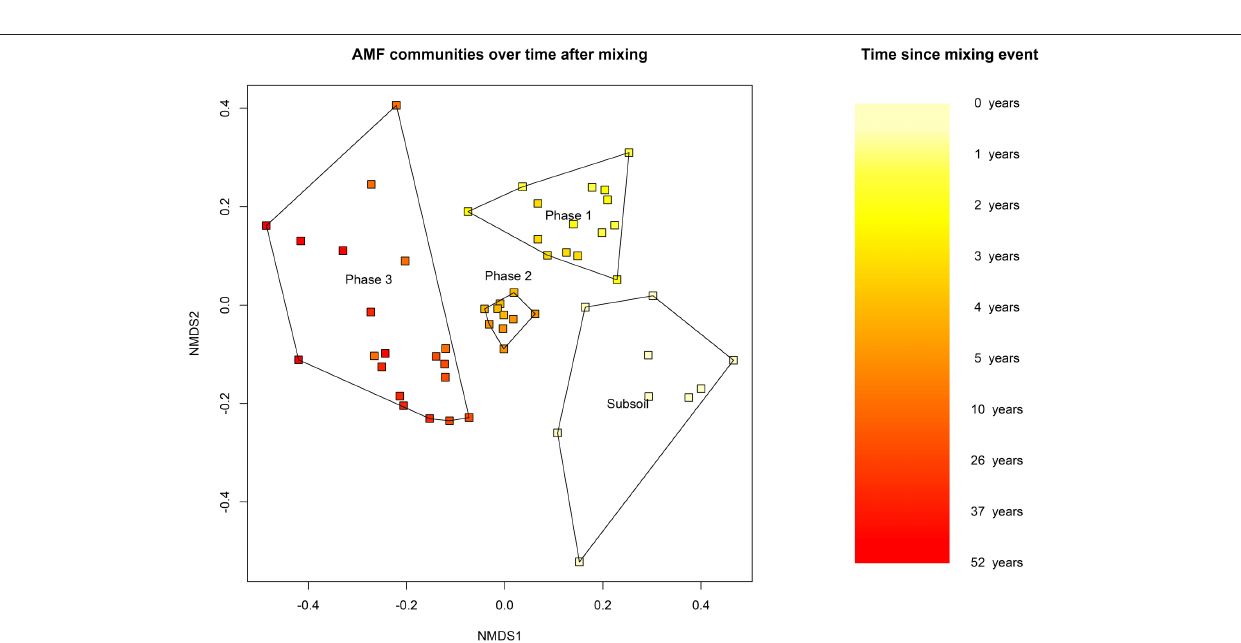
FIGURE 1 | Sub- and Topsoil indicators over time. Number of reads detected in the chronosequence fields, for each of the subsoil (A) and topsoil (B) indicators identified in the unmixed field. Horizontal axis represents the time since the recultivation started, in years. Different indicator OTUs are coded by color.